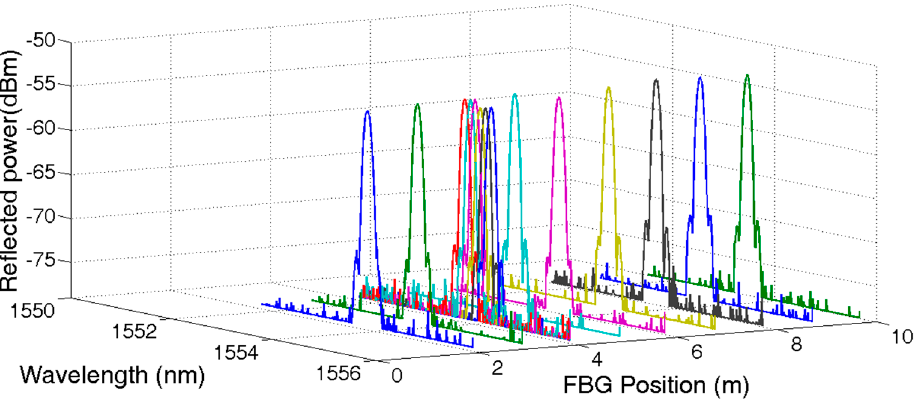
Figure 6. Reflective spectrum shift of UFBG3 during temperature measurement.